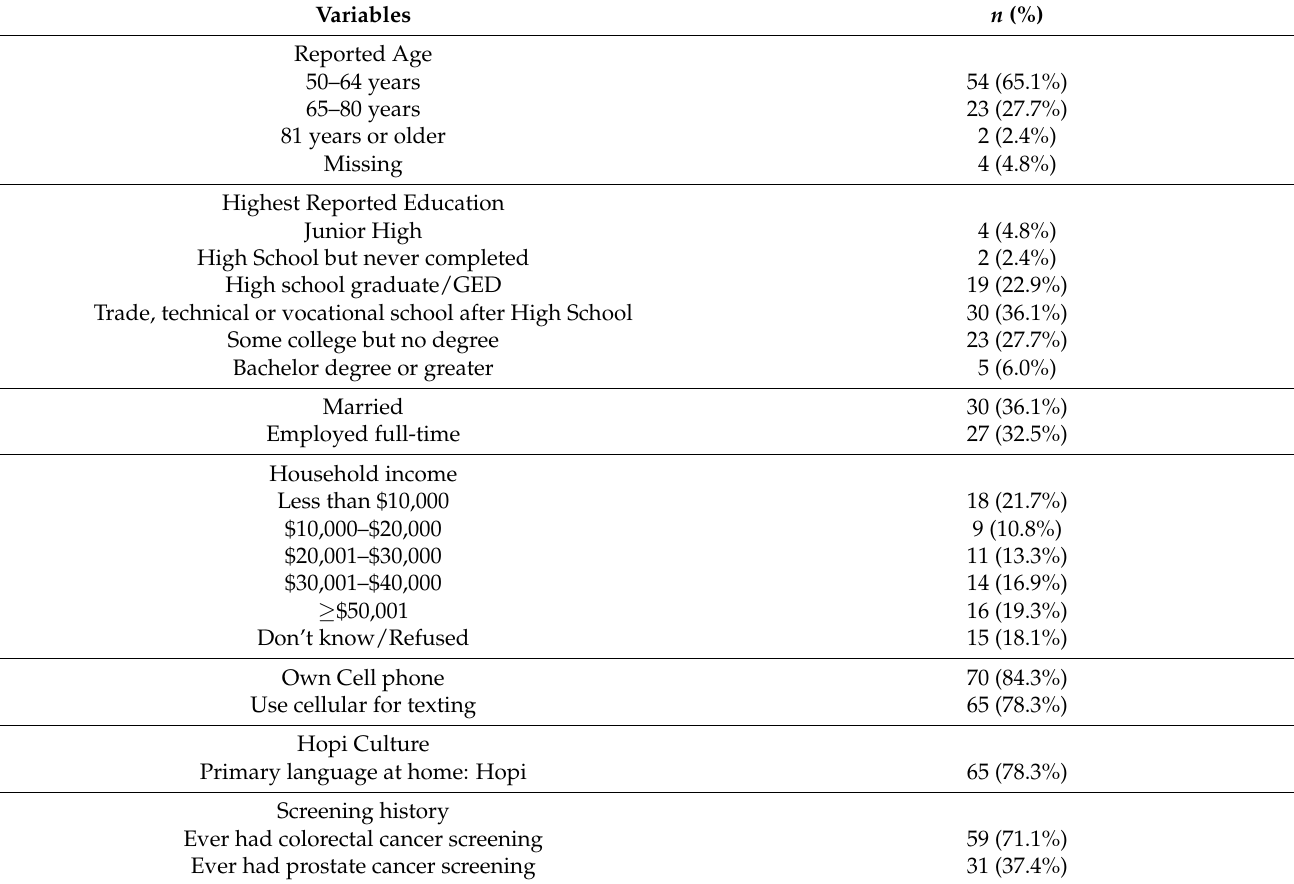
Table 1. Characteristics of Hopi men who participated the ARS surveys ( n =